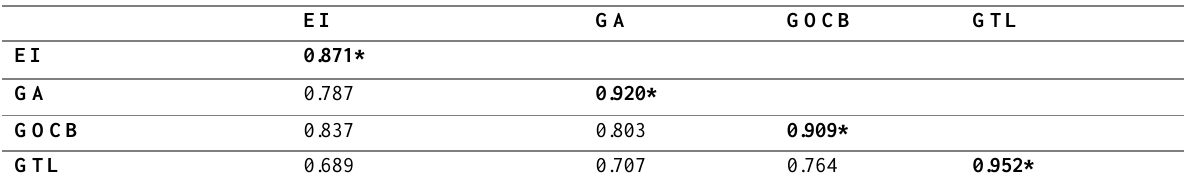
Table 3: Discriminant Validity